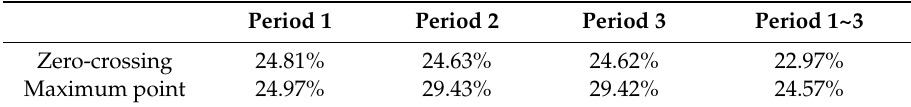
Table 1. Total harmonics distortion (THD) analysis of the cascaded output voltages, shown in Figures 10 and 11.